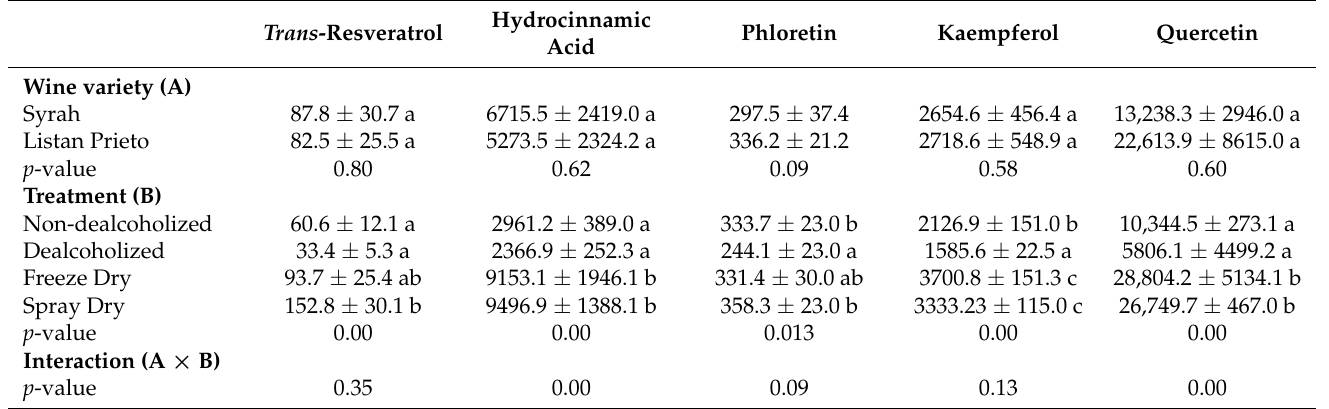
Table 3. Content of metabolites (ng 100 g − 1 DW) of treated wine